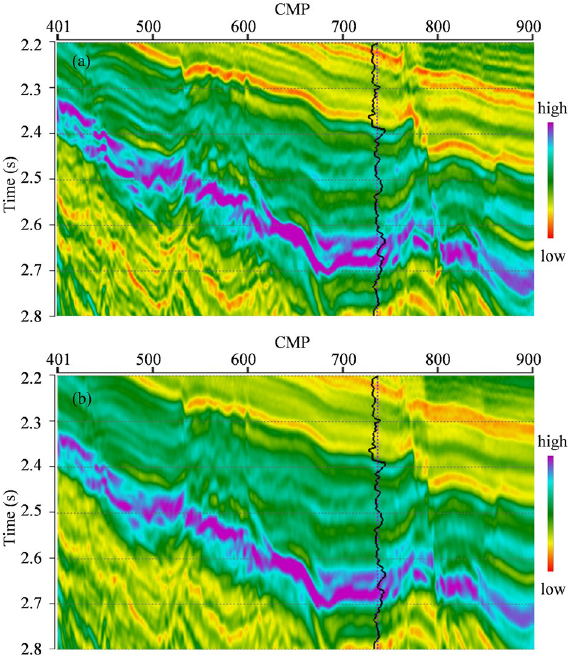
Figure 5. ( a ) Inverted impedance section by L 2,0 -MI. ( b ) Inverted impedance section by CSI.The black curve is the actual impedance well